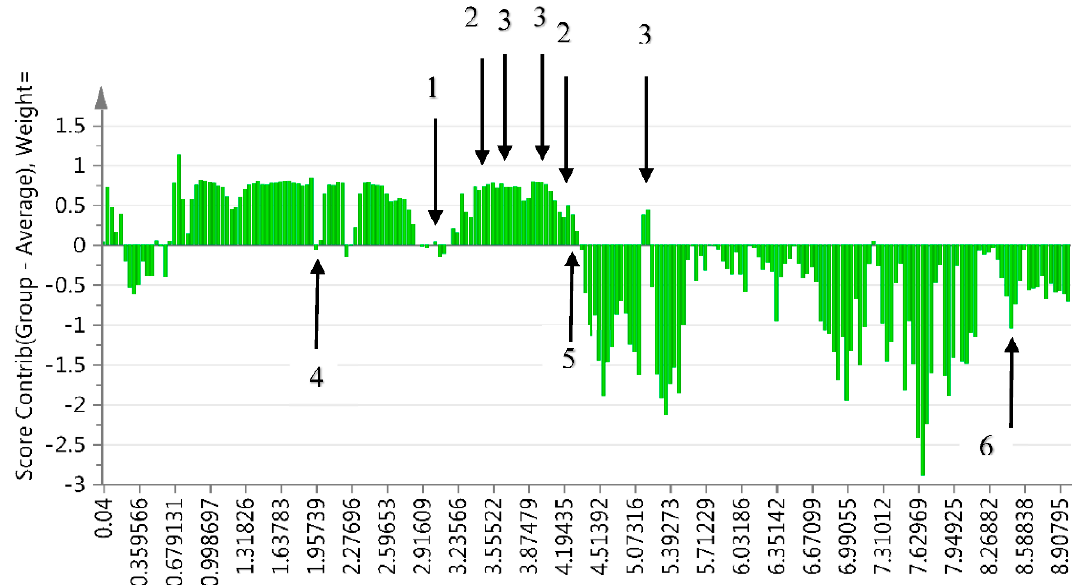
Figure 2. Contribution plot representing the differences between Burkea versus non-Burkea soils showing regions with positive correlation with Burkea soils for choline-like (1) (3.1 ppm), carnitine-like (1) (3.1 ppm), betaine (2) (3.3 and 3.9 ppm) and trehalose (3) (3.6, 3.8, 3.9 and 5.2 ppm) compounds and negative association for acetate (4) (1.9 ppm), lactate (5) (4.1 ppm) and formate (6) (8.4 ppm). Trehalose (3.6, 3.8, 3.9, 5.2 ppm), betaine (3.3 and 3.9 ppm), carnitine-like, and choline-like